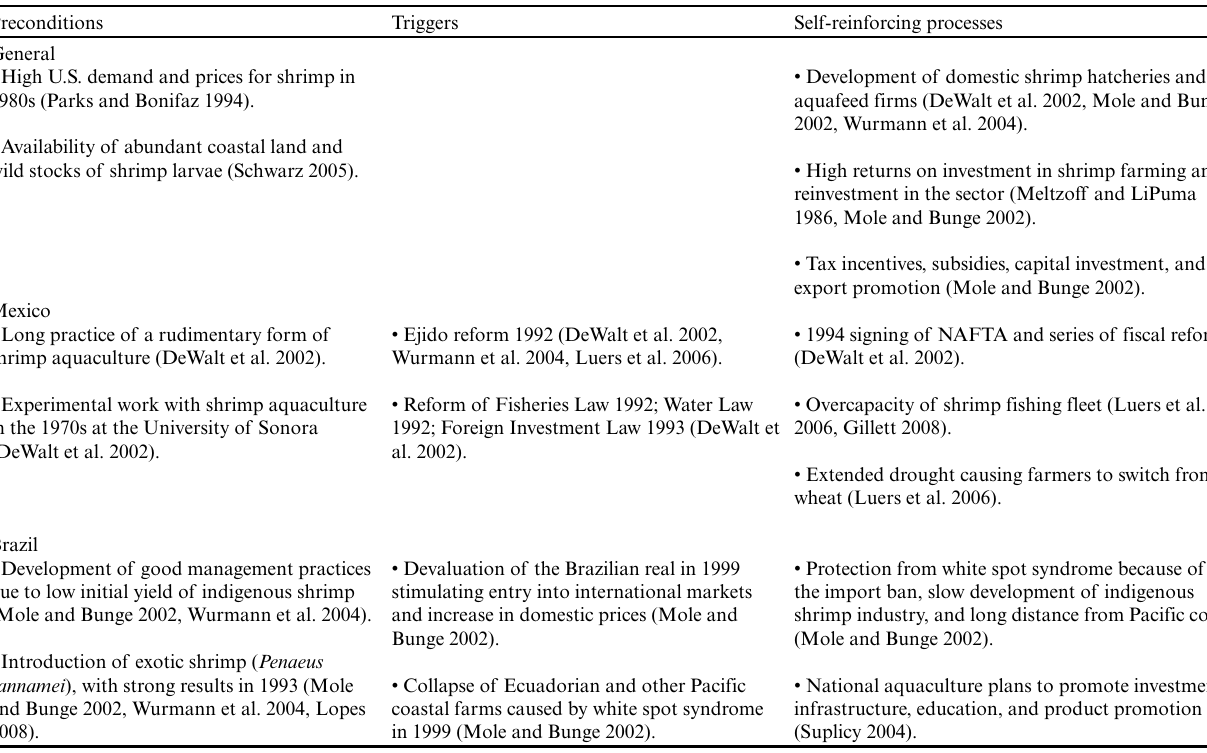
Table 2 . Preconditions, triggers, and self-reinforcing processes for a regime shift from artisanal fishing to shrimp production in Latin